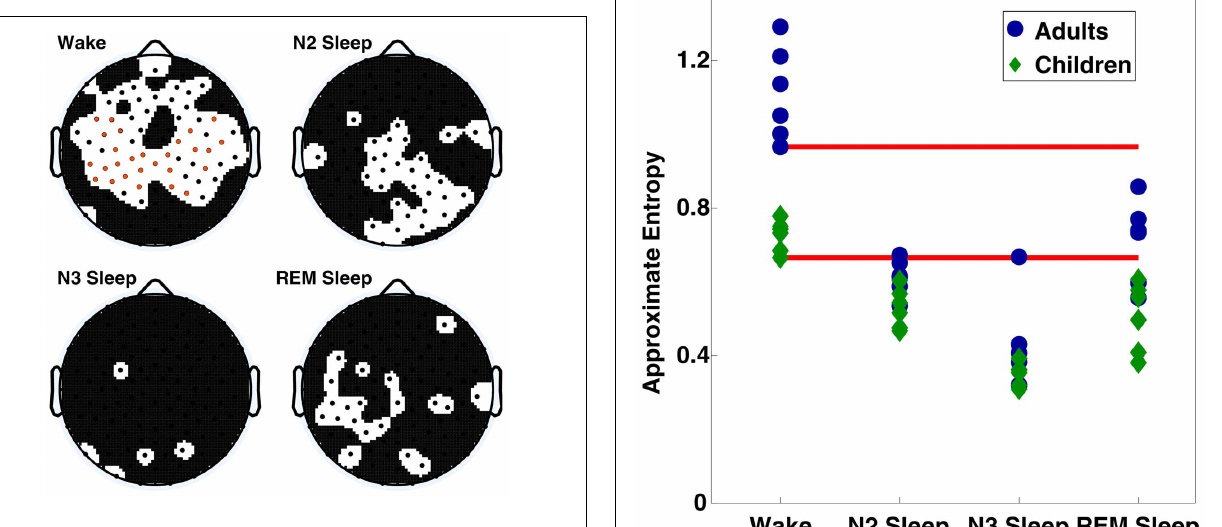
FIGURE 3 | Within vigilance state t -test p -values across all electrodes, electrodes for which p < 0 . 05 are displayed in black on the white background, values significant following Holm–Bonferroni correction are depicted in orange. The nasion electrode (not shown) was significantly different during wakefulness after post-hoc correction.